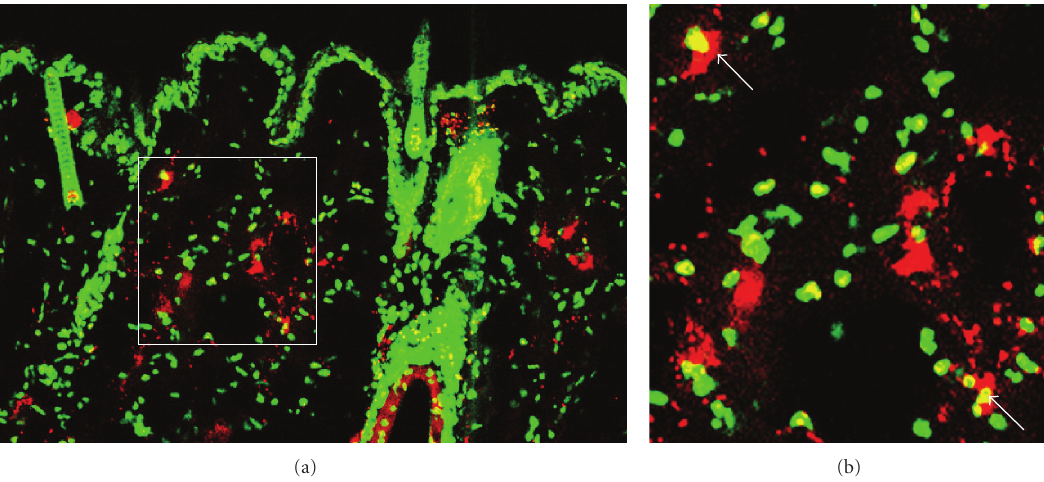
Figure 7: TUNEL-positive cells and mast cells in the UVA1-irradiated skin of MRL/lpr mice. Positive cells for TUNEL assay are shown in green, whereas mast cells are labeled with avidin-Texas Red to be shown in red, and merged images are shown. In the skin of UVA1-irradiated (10J/cm 2 ) mice, some double immunopositive apoptotic cells (yellow, indicated by arrows) were seen. (a): original magnification, × 200, (b): magnified image of the indicated region of